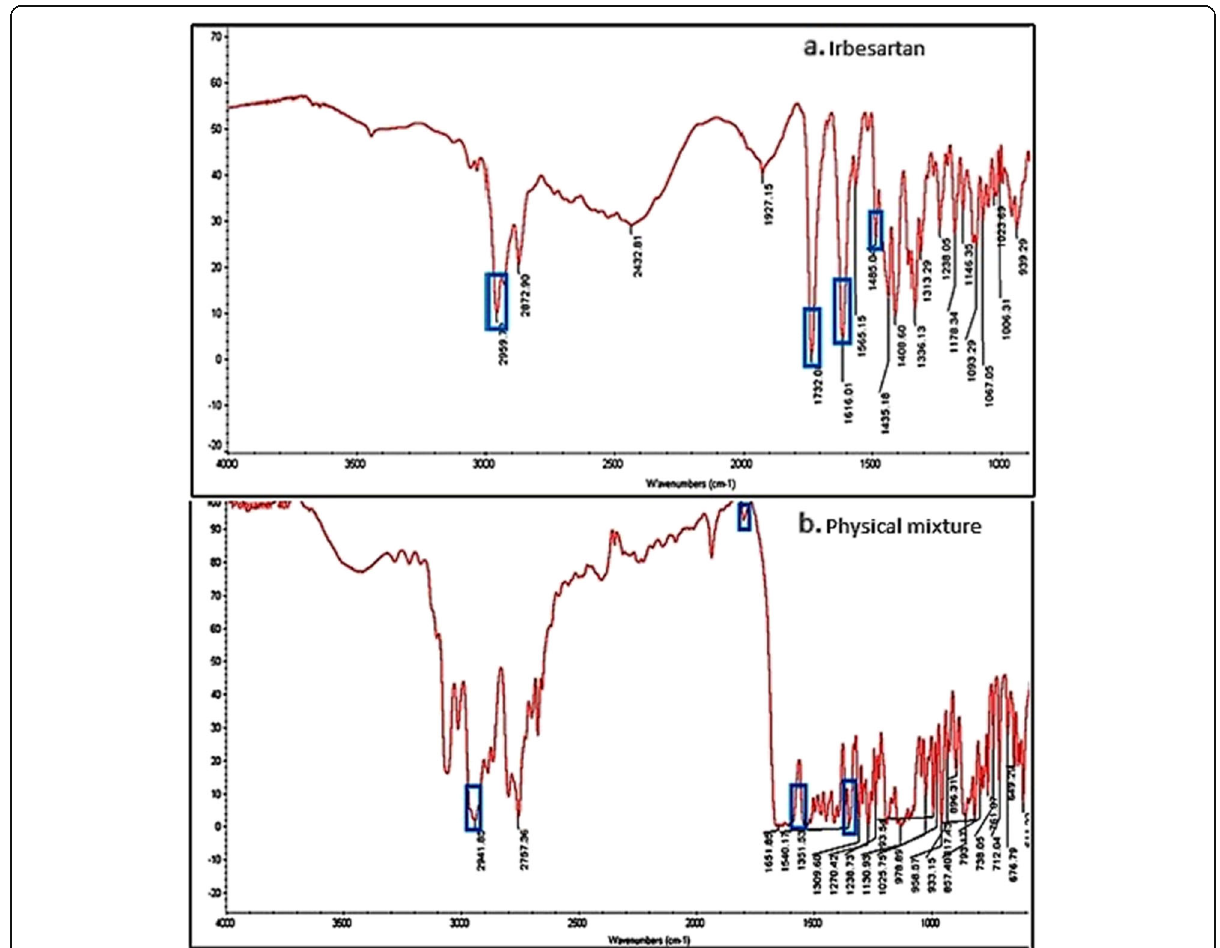
Fig. 1 FTIR spectra of irbesartan and physical mixture of irbesartan with